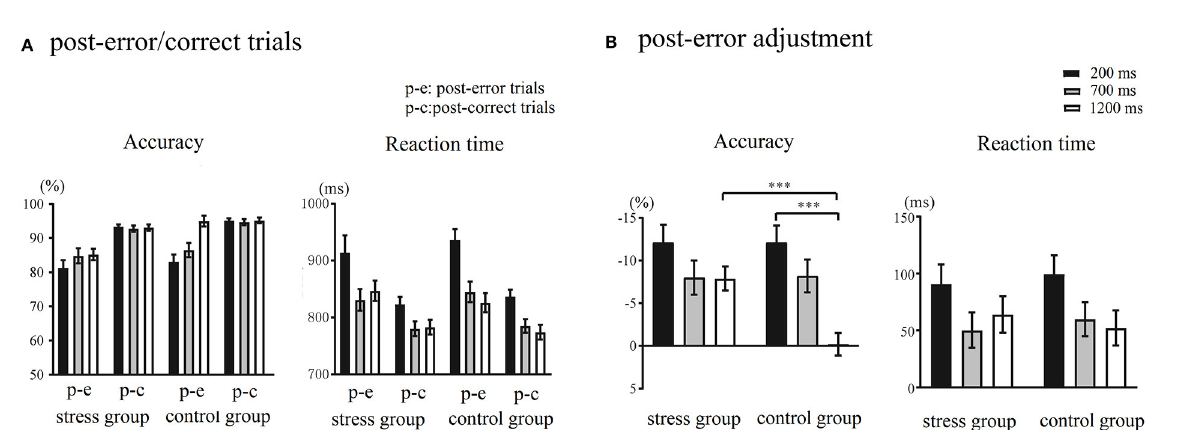
FIGURE3 (A) Accuracy and response times (RTs) of post-error/correct trials during different response stimulus intervals (RSIs) in the control and stress groups. (B) The post-error adjustment in accuracy and RTs in the control and stress groups. The calculation formula of anterior cingulate cortex (ACC): ACC post ACC post – ACC post . The calculation formula of RTs: RTs post − error adjustment = − error trial − correct trial RTs post . *** p < − correct trial